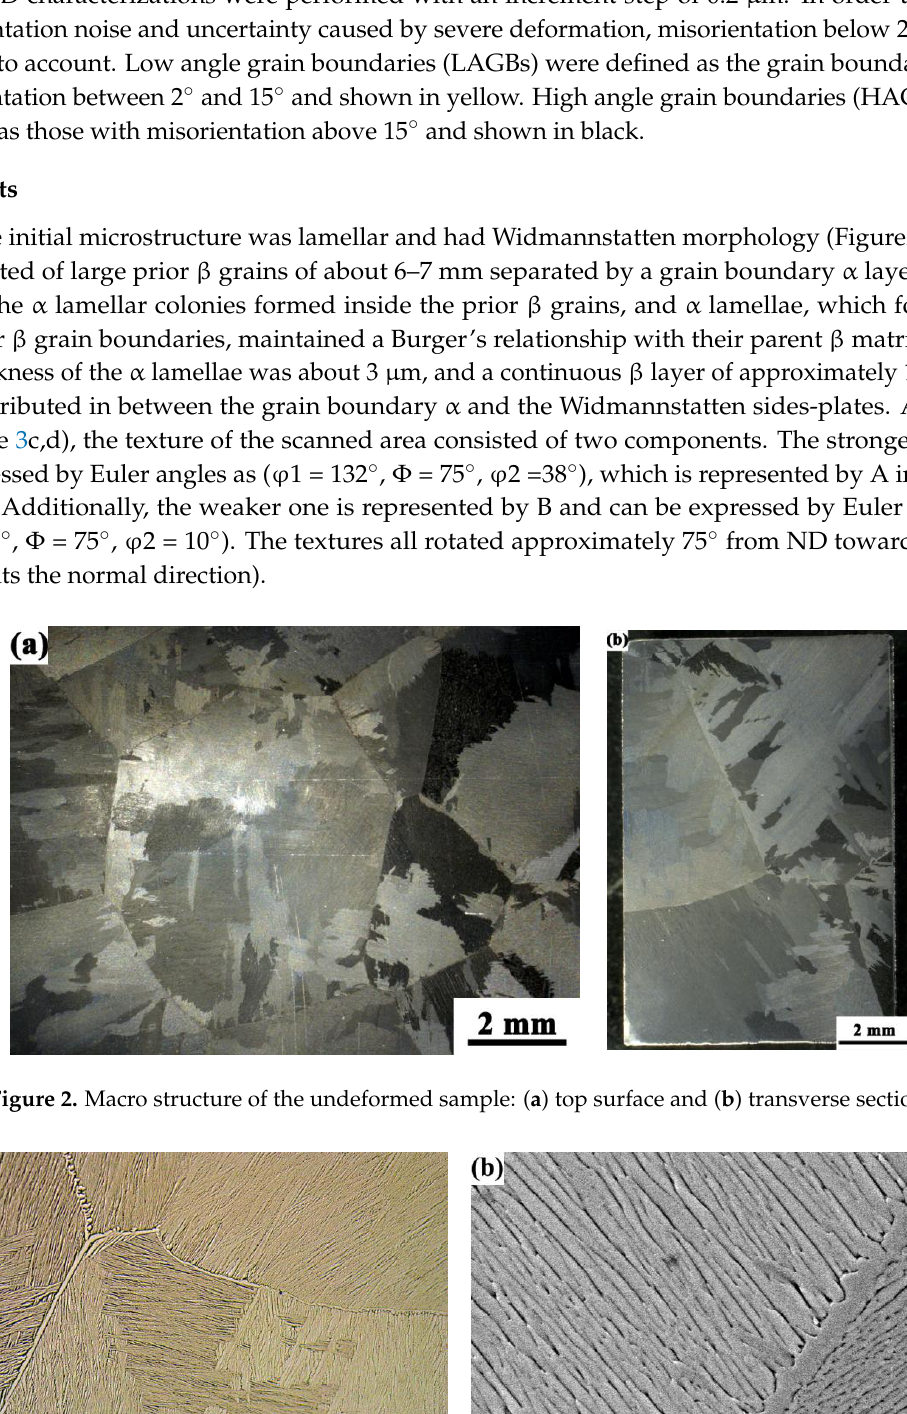
Figure 1. Schematic of isothermal compression and viewing position (CD and TD represents compressing direction and tranverse direction, respectively): ( a ) undeformed sample, ( b ) deformed sample, ( c ) sample position.